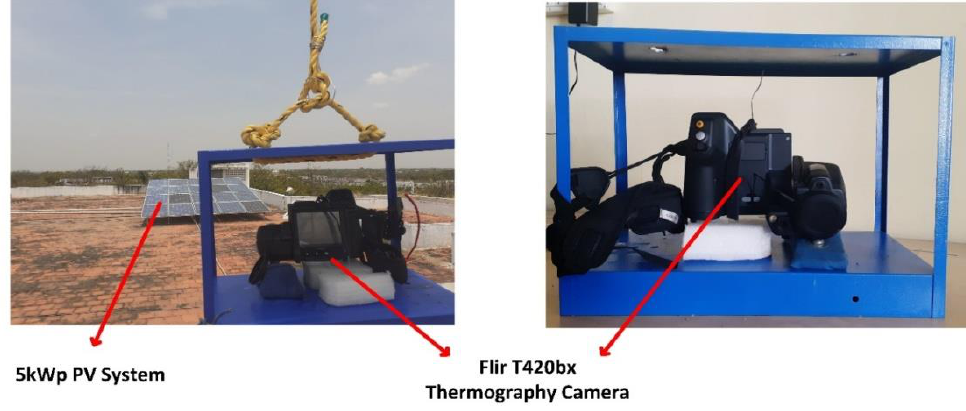
Figure 11. Photograph of thermal camera arrangements.